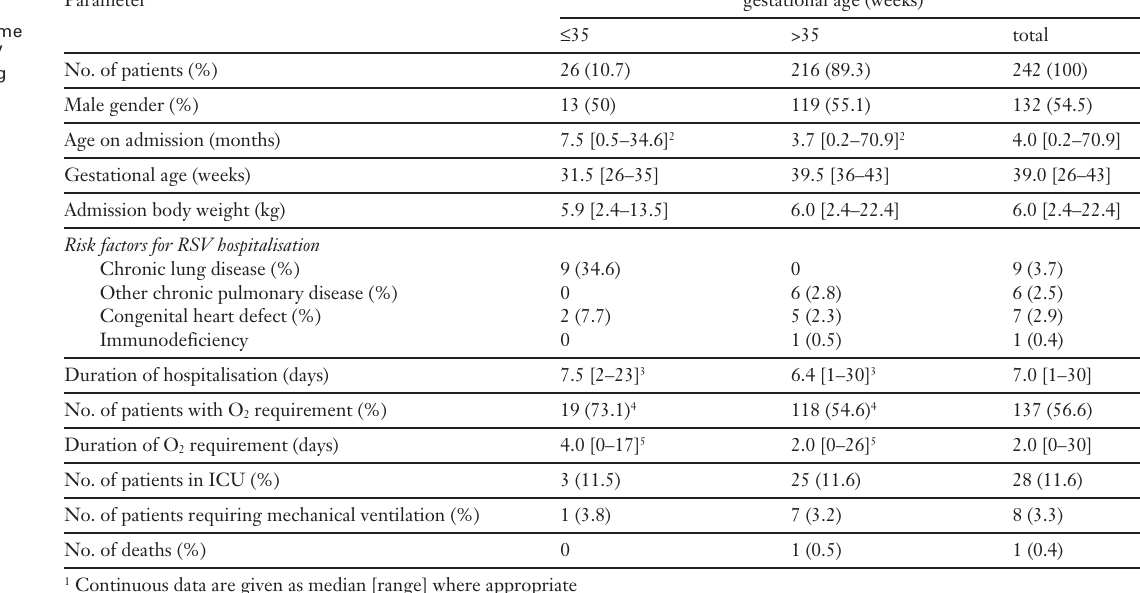
Table 1 Clinical and outcome parameters of RSV infection according to gestational age.